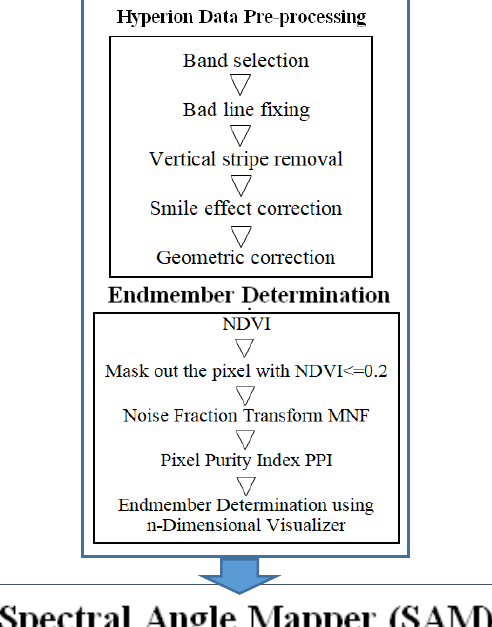
Figure 1. Methodology workflow